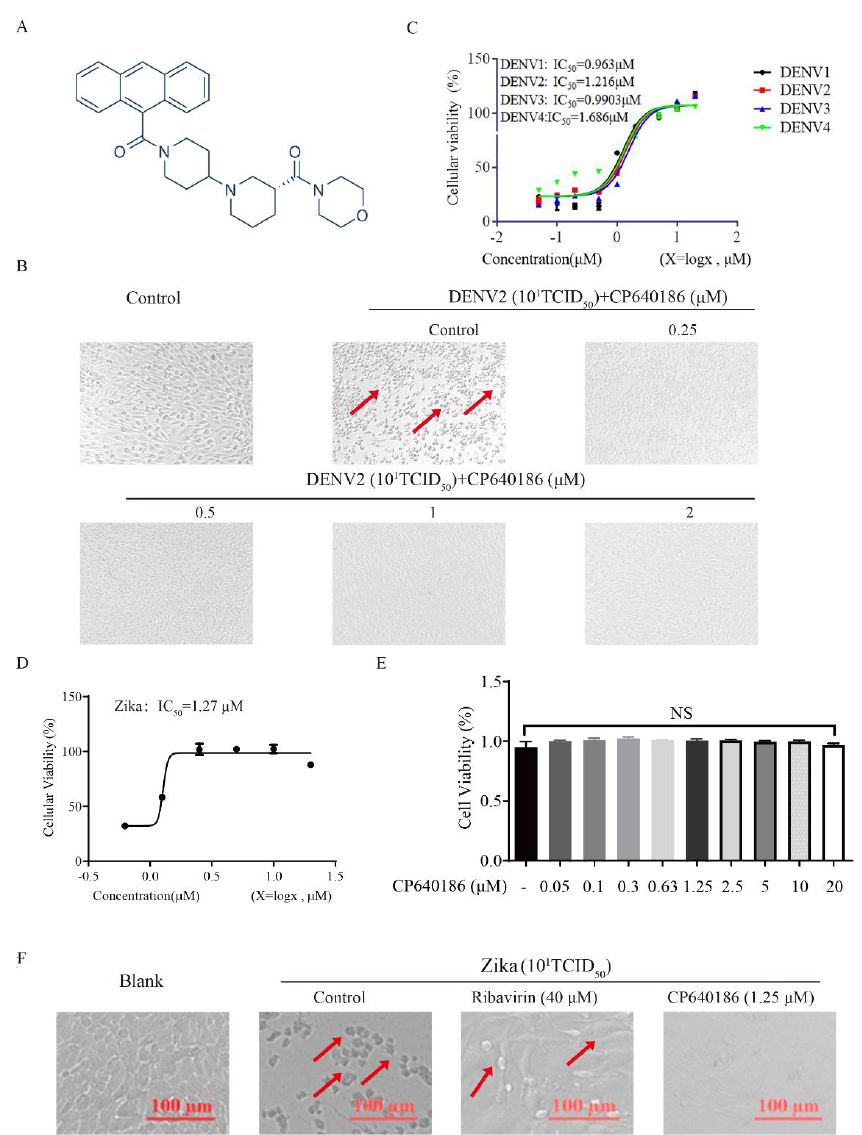
Figure 1. The antiviral ability of CP640186 against DENV2 and Zika. ( A ) The chemical structure of compound CP640186. ( B ) Cytopathic effects were observed after DENV2 infection in the presence of CP640186 at the indicated concentrations. ( C ) The IC 50 of CP640186 against DENV1–4. ( D ) The IC 50 of CP640186 against Zika virus. ( E ) The cytotoxicity effect of CP640186 on BHK-21 cells. ( F ) The cytopathic effect of CP640186 against Zika in Vero cells. Each experiment was repeated 3 times and column data represent mean ± SD.